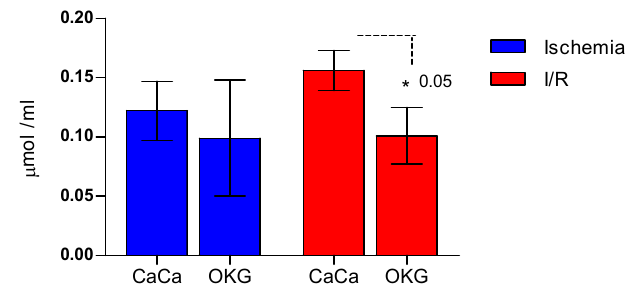
FIGURE 3 - Tissue pyruvate levels (micromoles per gram of fresh tissue) in samples from CaCa and OKG-pretreated rats. Bars represent mean±SD of ischemia (blue bars) and reperfusion (red bars) groups at the end of the ischemia (30 min) and reperfusion (30 min). Pyruvate levels in OKG treated rats decreased significantly at the end of reperfusion compared with CaCa-treated rats by Student´s t